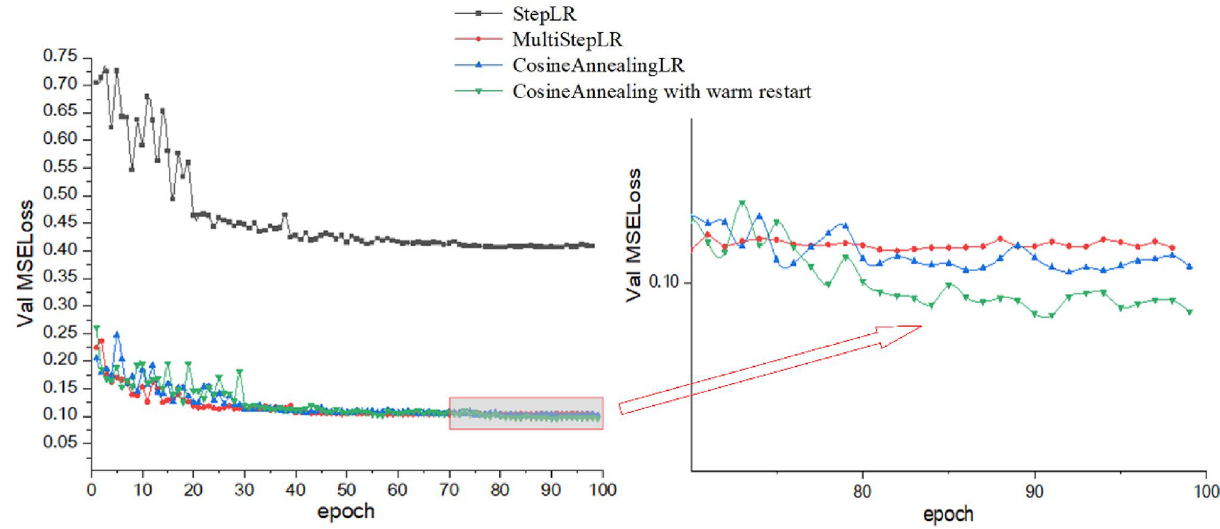
Figure 6. MSE loss curves of validation set for different learning rate decay